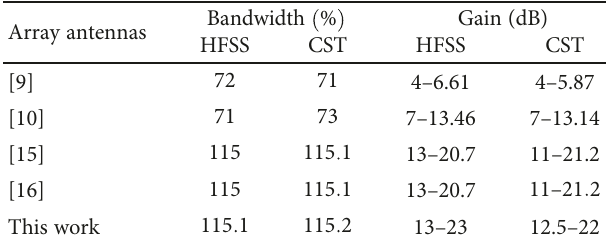
Table 4: Compared result between HFSS and CST. Array antennas